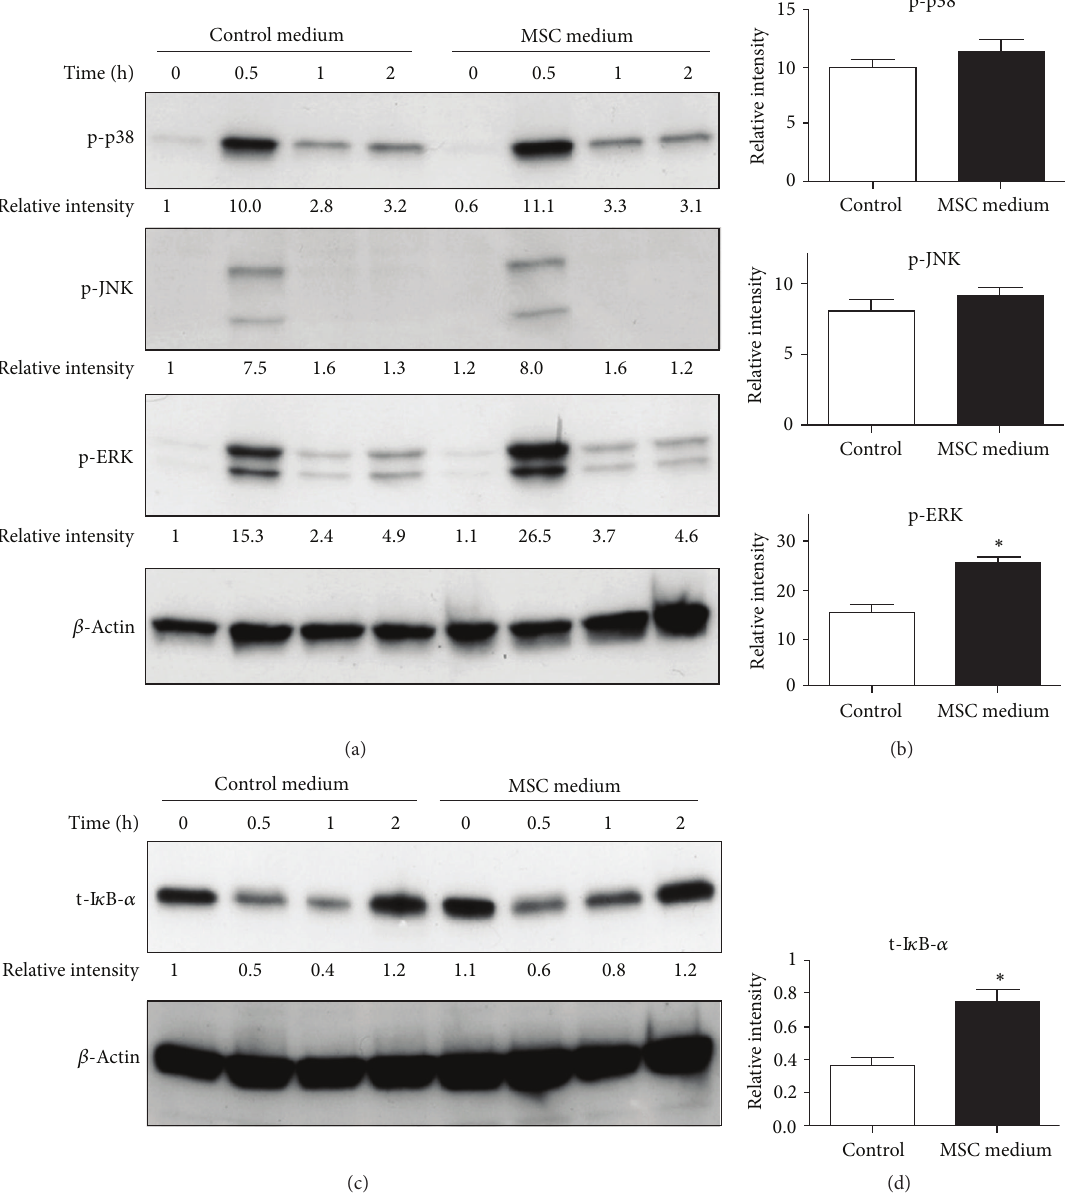
Figure 4: Enhanced ERK and suppressed NF- 𝜅 B signaling in BMDMs incubated in MSC-conditioned medium and then subjected to R848 stimulation. BMDMs were preincubated for 1h in MSC-conditioned medium or control medium, after which R848 (TLR7/8 ligand, 10 𝜇 g/mL) was added. Cells were further incubated for the indicated times. (a) The levels of p-p38, p-JNK, and p-ERK were determined by immunoblotting. Beta-actin was used as a loading control. Relative band intensities ware quantified by densitometry analysis. (b) The data of (a) at 0.5 h after R848 stimulation obtained by densitometric analysis are shown as the mean ± SEM of 3 independent experiments. (c) The level of total I 𝜅 B- 𝛼 was determined by immunoblotting. Beta-actin was used as a loading control. Relative band intensities ware quantified by densitometry analysis. (d) The data of (c) at 1h after R848 stimulation obtained by densitometric analysis are shown as the mean ± SEM of 3 independent experiments. ∗ 𝑃 < 0.05 , compared to the control medium